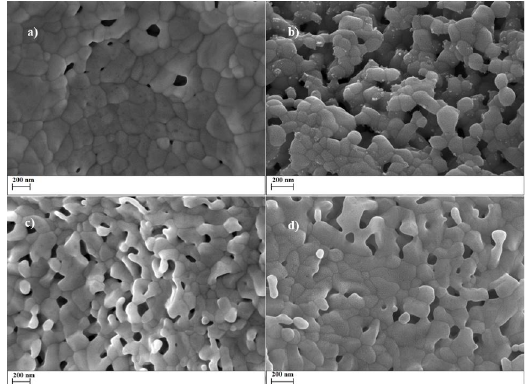
Figure 4. SEM images of cerium molybdate powders (a = 450 ºC; b = 500 ºC; c = 600 ºC; d = 800 ºC).